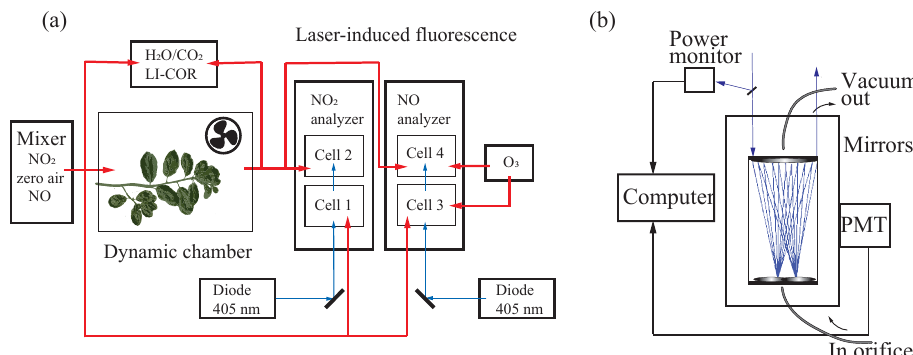
Figure 2. Schematic of the experimental dynamic chamber (a) and laser-induced fluorescence detection (b)